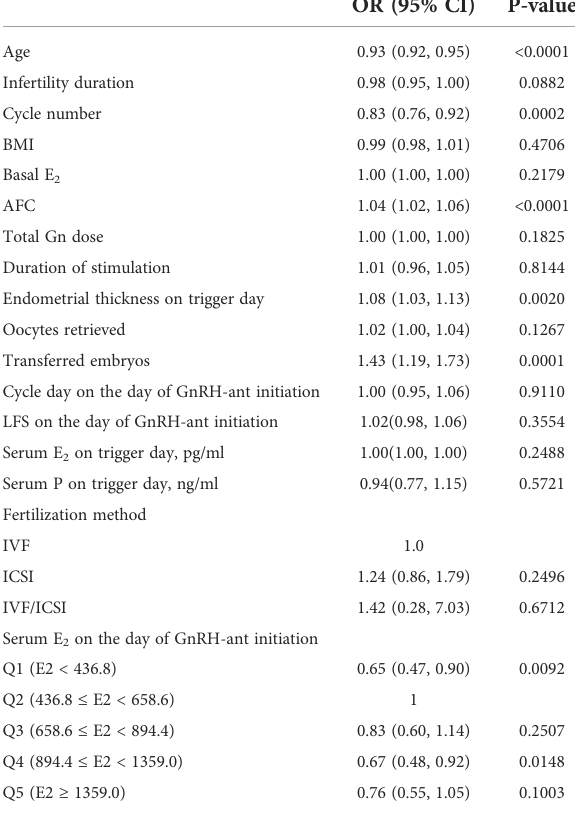
TABLE 2 Univariate logistics regression analysis for clinical pregnancy.